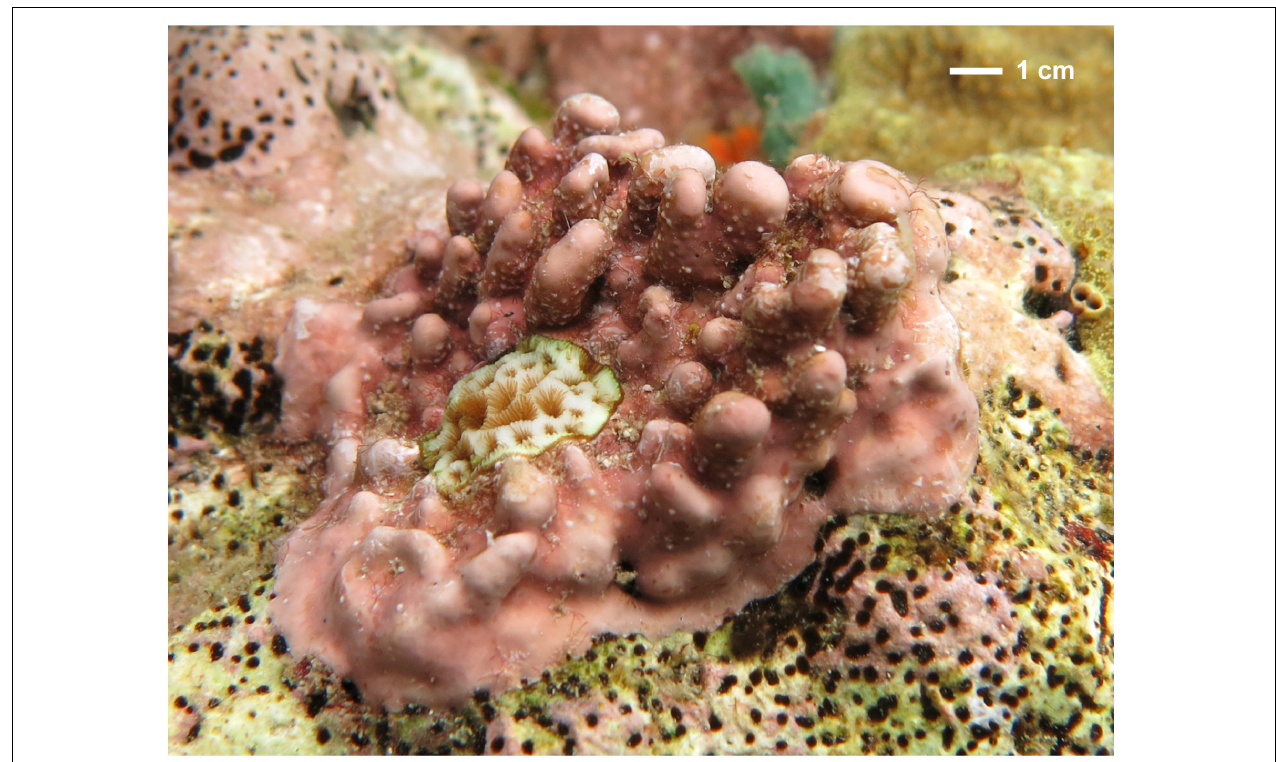
FIGURE 1 | Fragments of Lithophyllum congestum , a common reef-building crustose coralline alga on Caribbean coral reefs, were collected from a shallow coral reef in Bocas del Toro, Panamá and exposed to a combination of stable and variable pH treatments for 16-weeks. Though a coral is pictured alongside the CCA in situ , the fragments used in the experiment were comprised solely of L. congestum